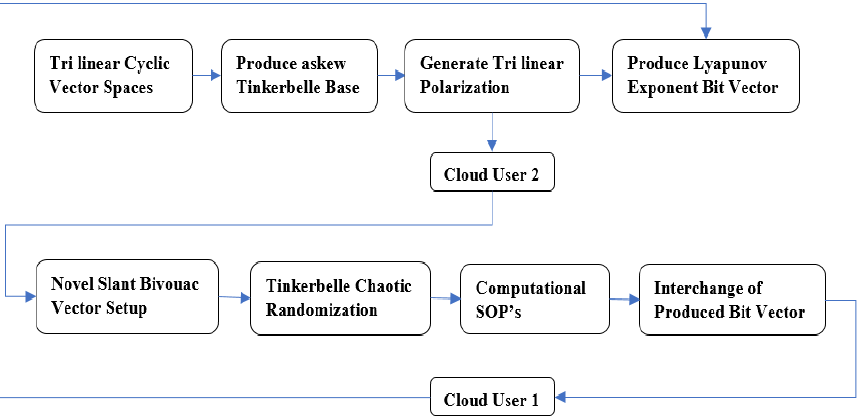
Figure 3. Proposed Polygon Polarization Based QHCP ‐